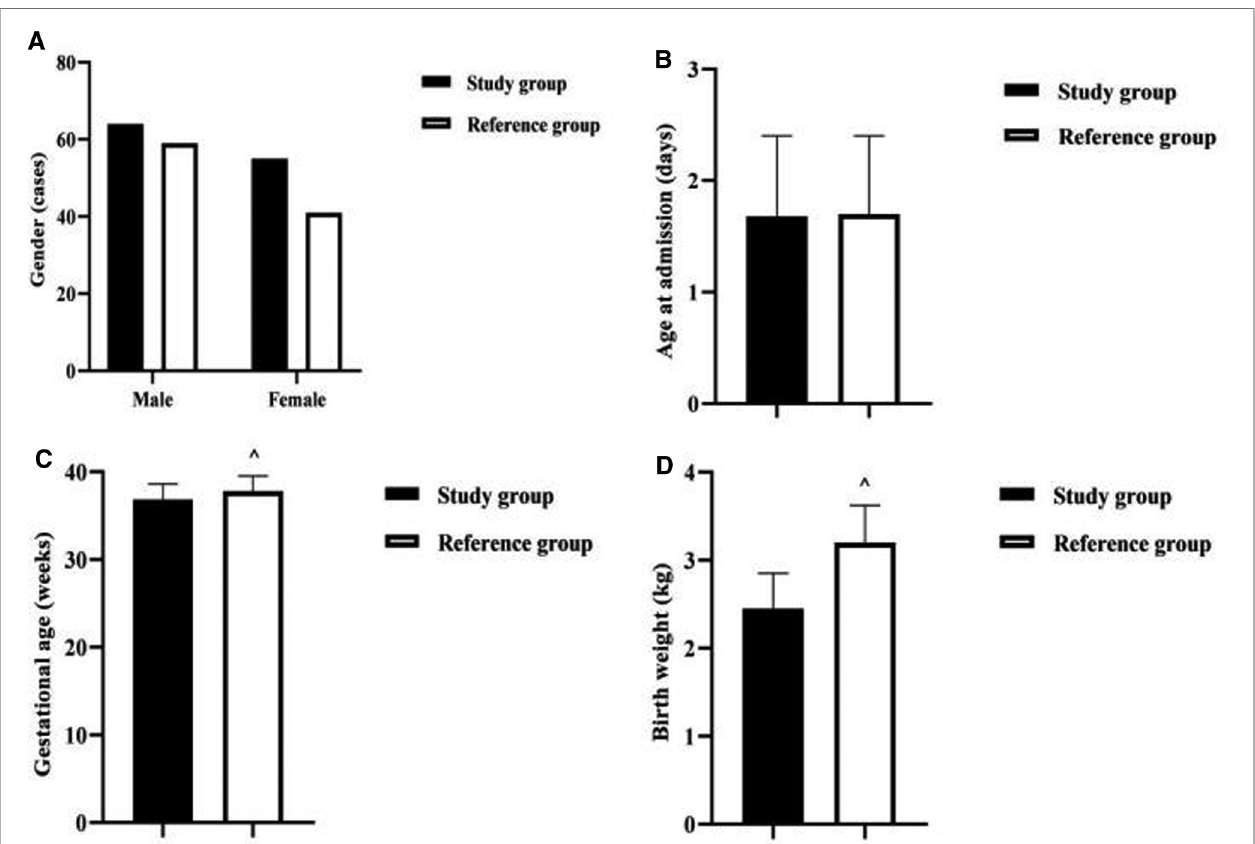
FIGURE 1 | Comparison of baseline information between the two groups of newborns. Note: ( A ) Comparison of neonatal gender between the two groups. ( B ) Comparison of neonatal age at admission between the two groups. ( C ) Comparison of neonatal gestational age between the two groups. ( D ) Comparison of neonatal birth weight between the two groups. Comparison with the study group ^ P